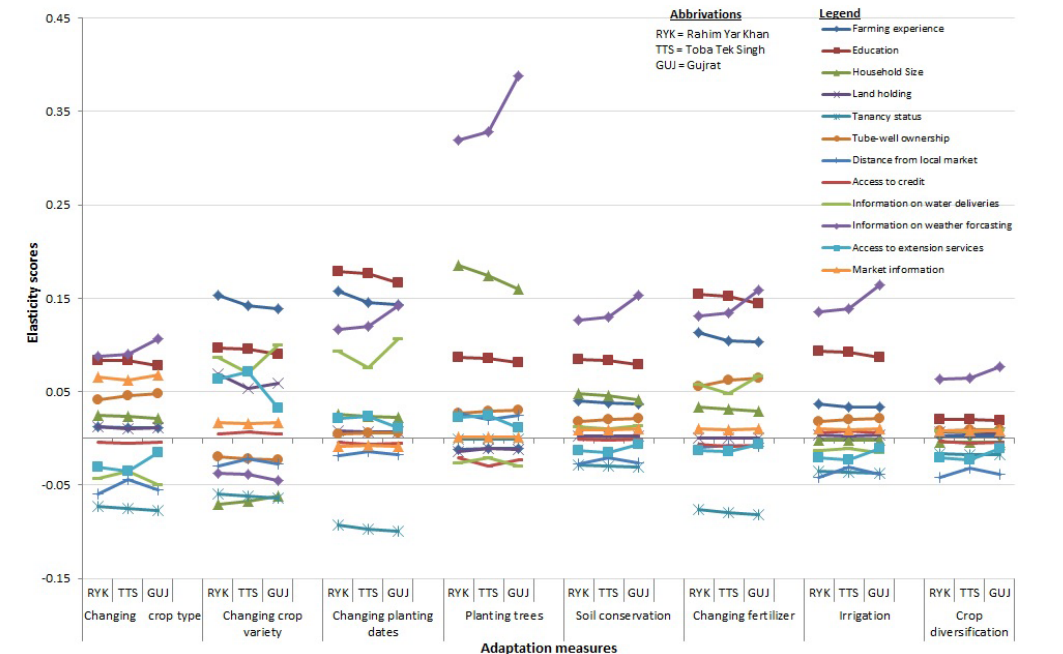
Figure 10. Partial elasticity calculations across three study districts of Punjab